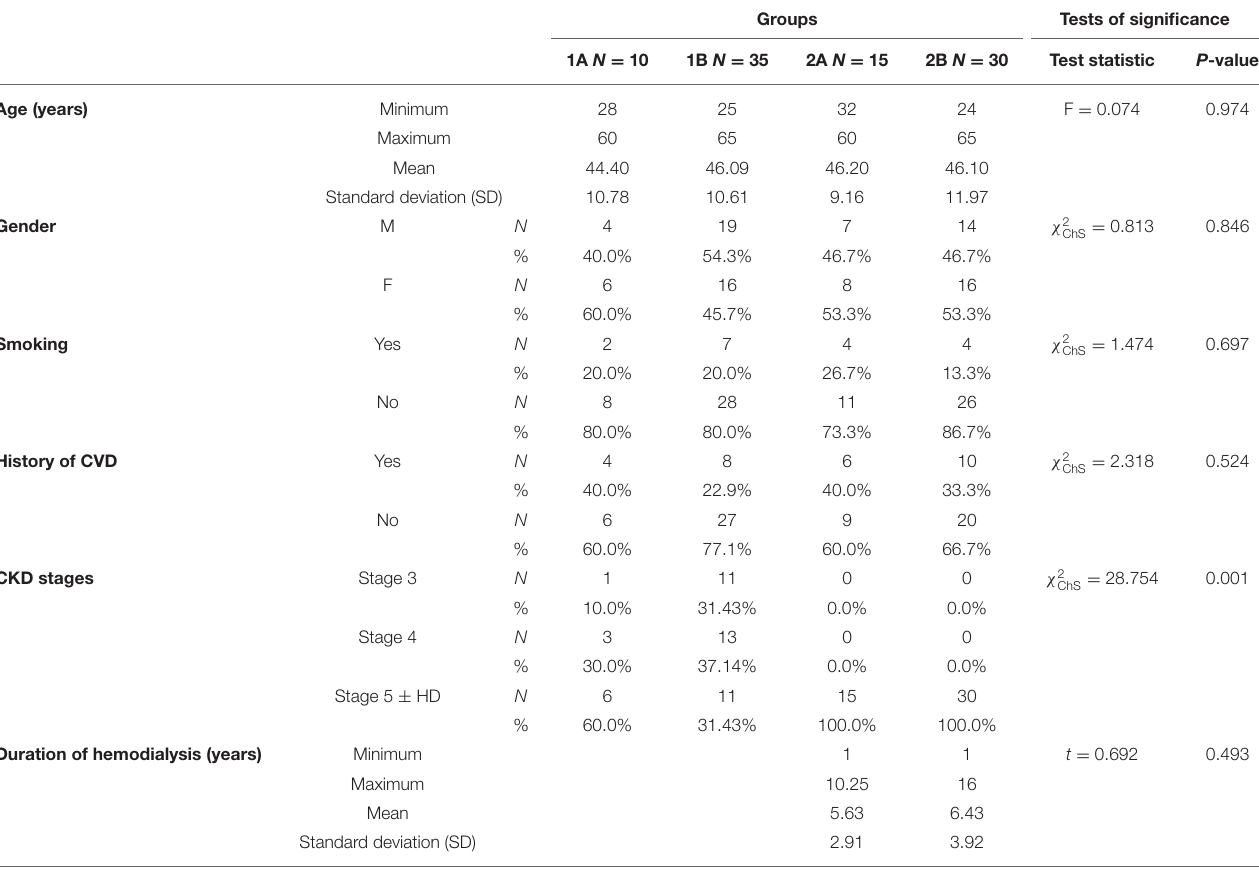
TABLE 2 | Clinical and demographic characteristics of the studied groups.